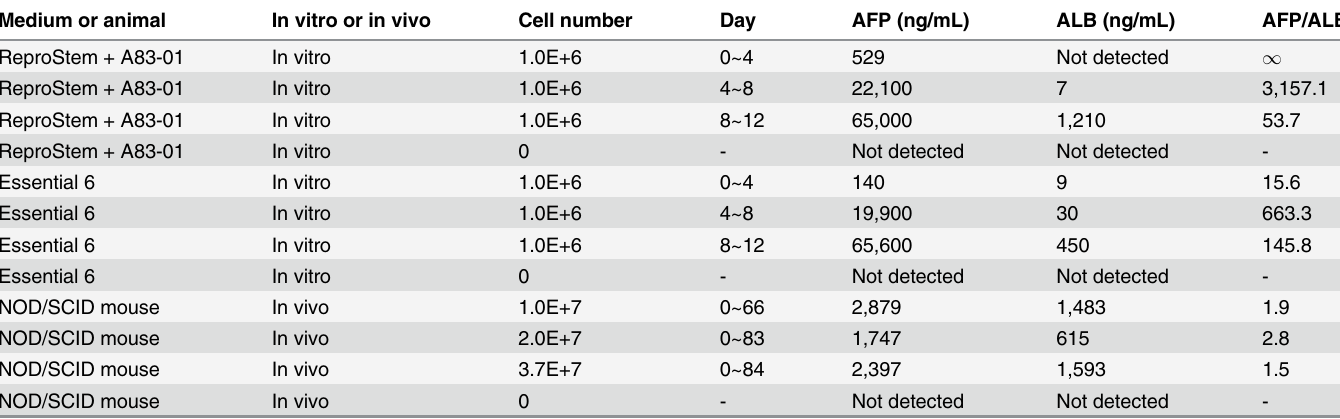
Table 1. The secretion of AFP and ALB in vitro and in